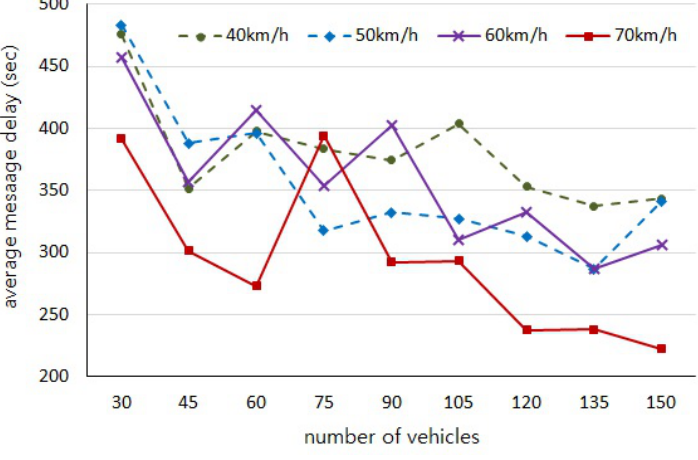
Figure 7. Average message delivery delay ( D ) from contact point RSUs to the destination vehicles.